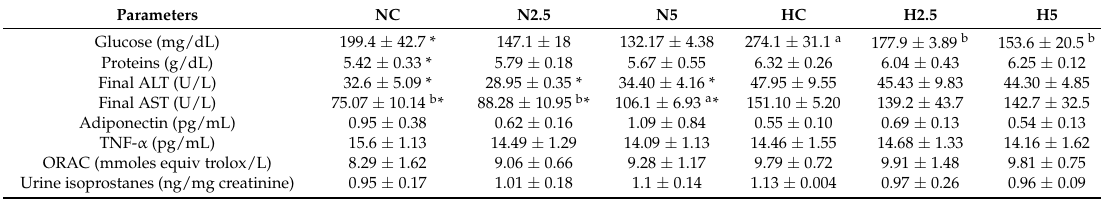
Table 3. Biochemical parameters of plasma, inflammation and oxidative stress biomarkers analyzed in the six experimental groups at the end of the 5-week intervention period 1